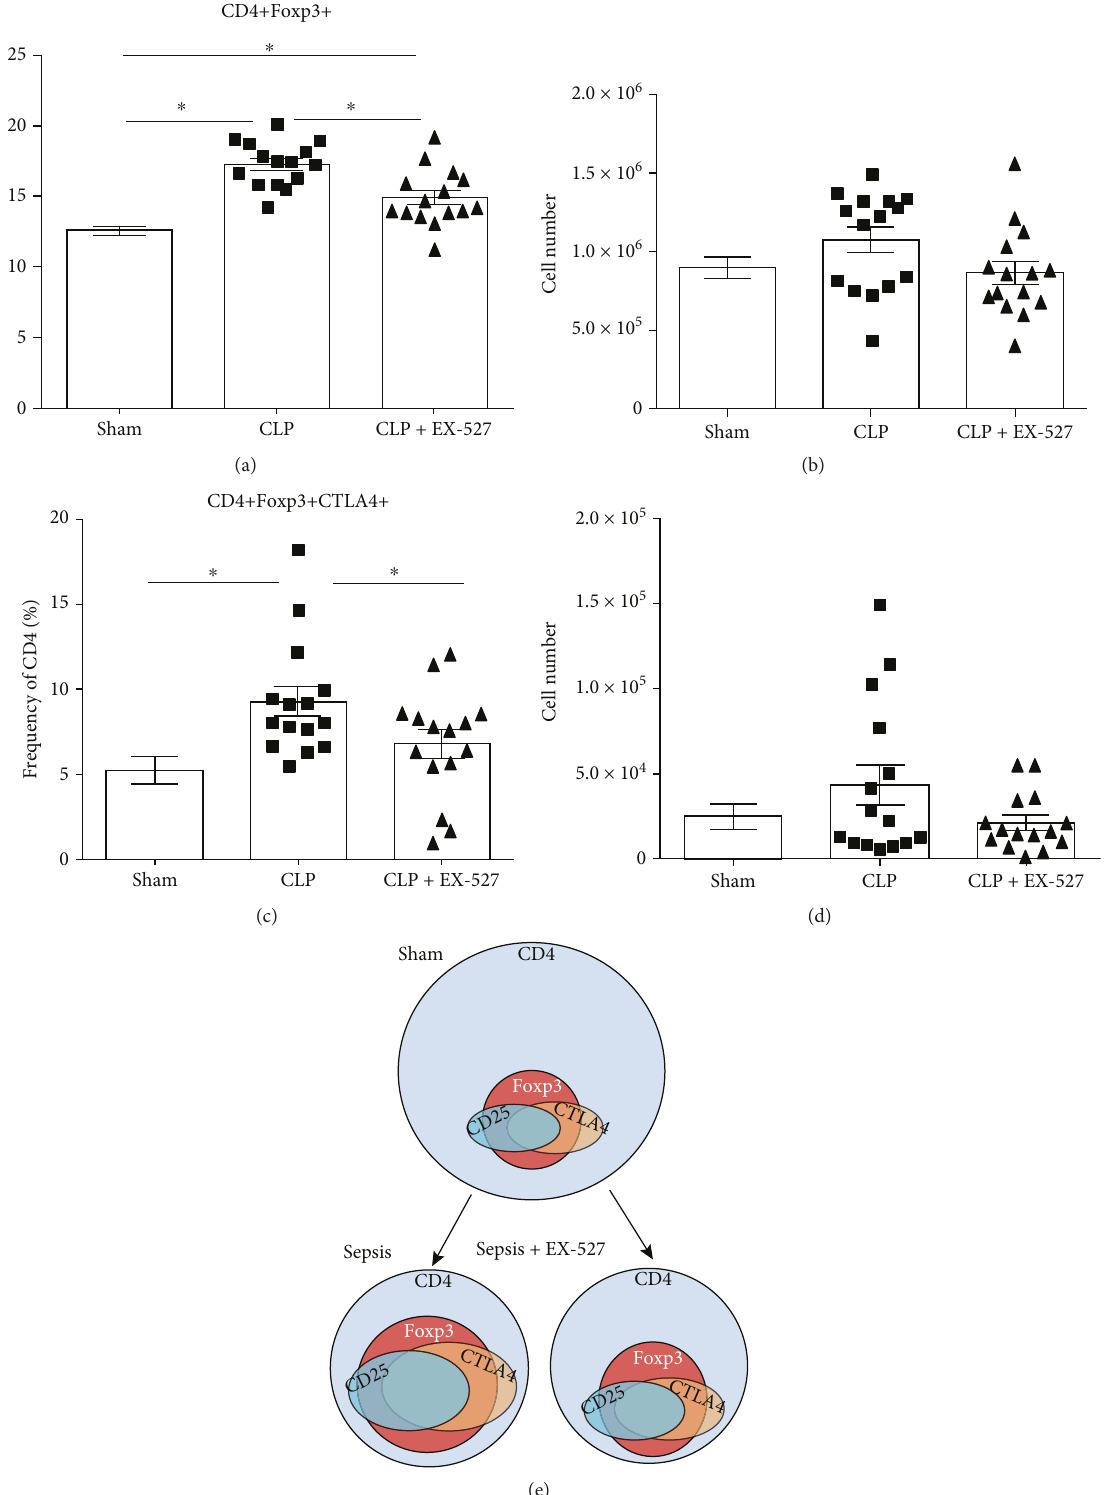
cells presented Reg